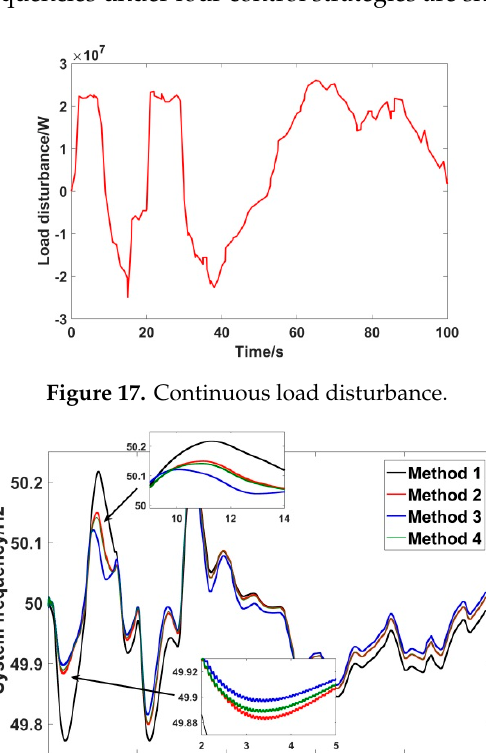
Figure 16. Results of 22 MW step load disturbance.